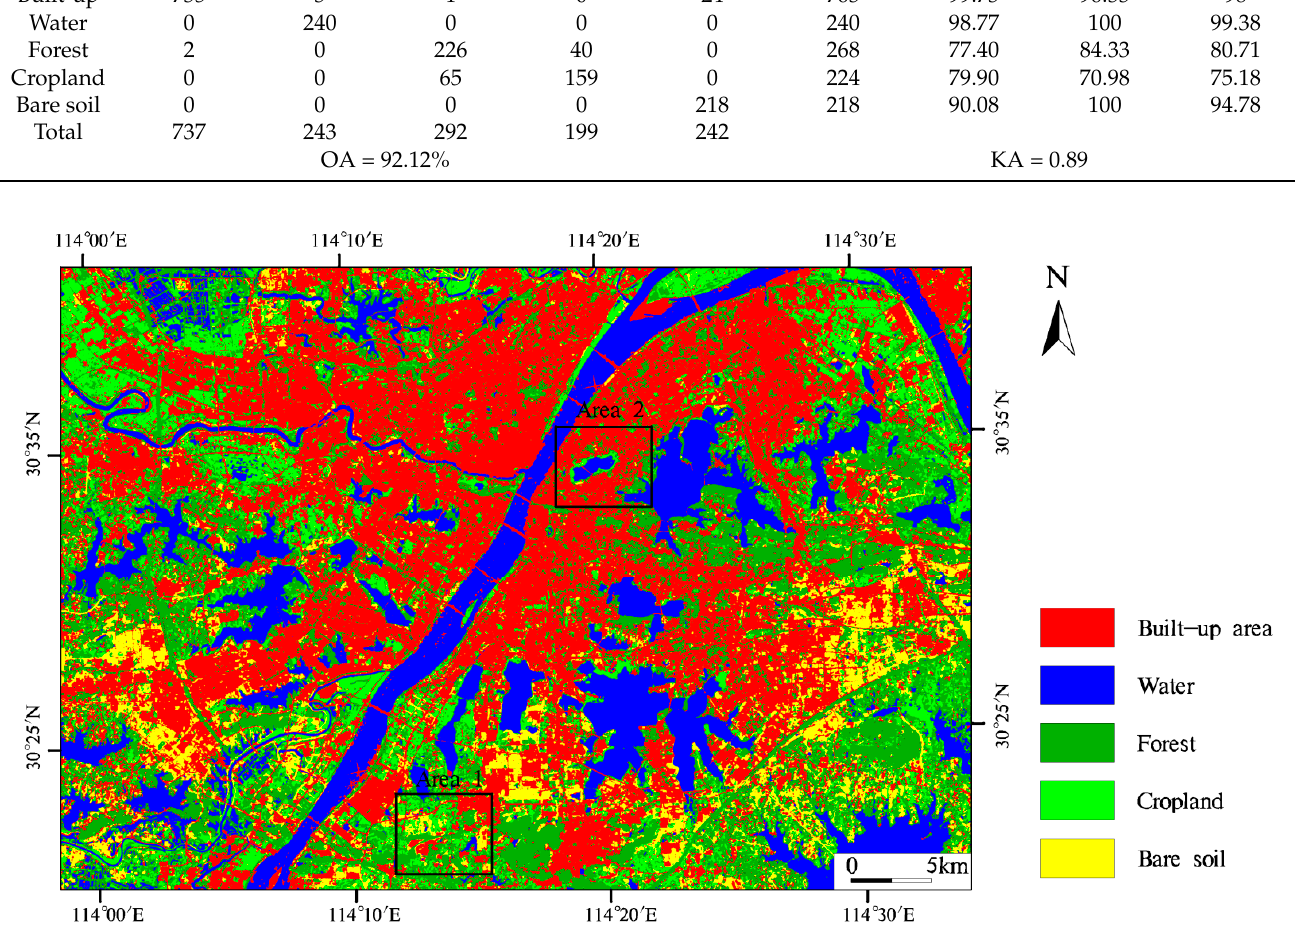
Figure 6. Land cover map obtained from the SVM-CK algorithm with the combination of Sentinel-2B MSI and Sentinel-1A SAR images.